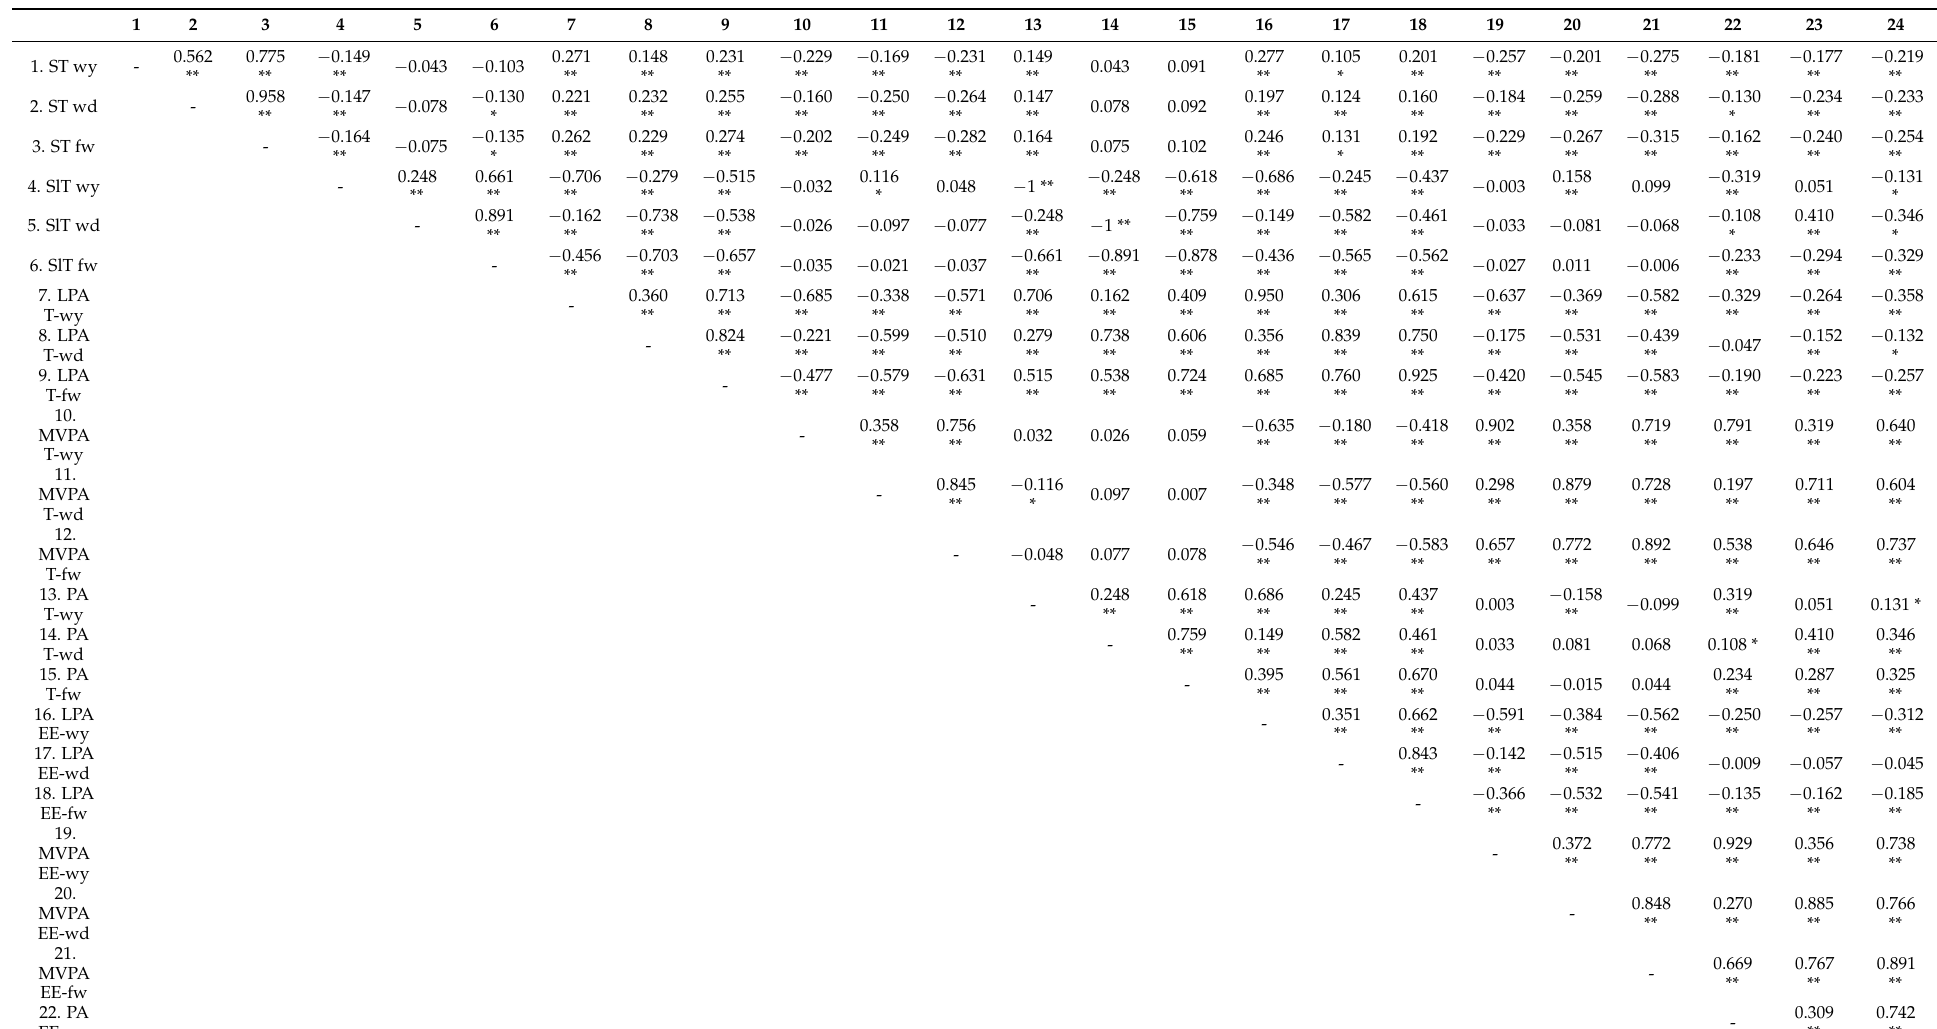
Table 3. Bivariate correlation between screen time, sleep time and physical activity for